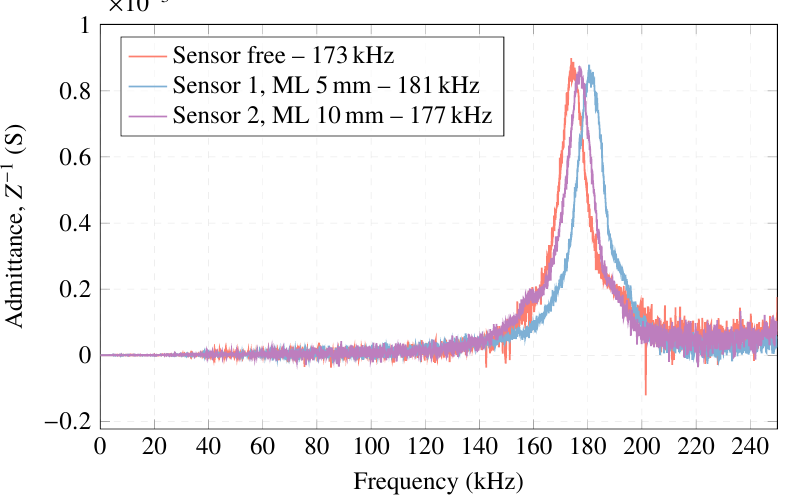
Figure 15. Electrical admittance measurement with the sensors attached to the matching layer compared to free